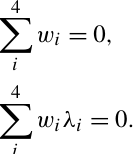
level, and F 0 are the individual extra-terrestrial constants at each wavelength. The weights w = [ 1 , − 0 . 5 , − 2 . 2 , 1 . 7 ]